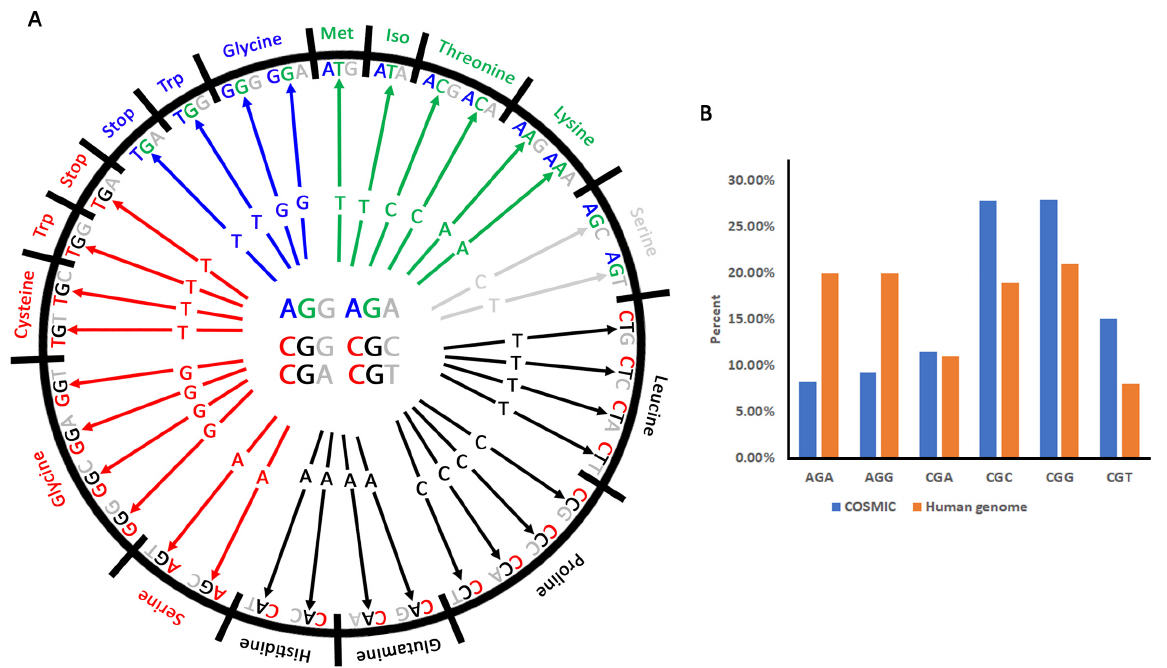
Figure 1. Possible amino acid substitutions from the six arginine codons. ( A ) Diagram showing base pair changes of the six arginine codons that can lead to amino acid substitutions and stop codons. Each arrow points to a base pair change within the six codons and its corresponding amino acid substitution. For simplicity, each base of the six codons is color-coded to correspond with the arrow. For example, if the first red C base of the CGG codon is changed to a T , it will produce a TGG codon which substitutes tryptophan for arginine. Note that some substitutions are more likely than others. Synonymous substitutions are not shown. ( B ) Arginine codon usage in human cancer and non-cancer cells. The graph shows all the reported arginine substitutions in cancer cells on COSMIC (765,956 counts in 69,455 unique cancer samples, blue bars) compared with observed arginine codon usage in human non-cancer cells (orange bars) as reported on GenScript (https://www.genscript.com/tools/codon-frequency-table, accessed on 5 November 2021). Values are plotted as a percentage of each codon usage compared with total usage. These data largely agree with [22].